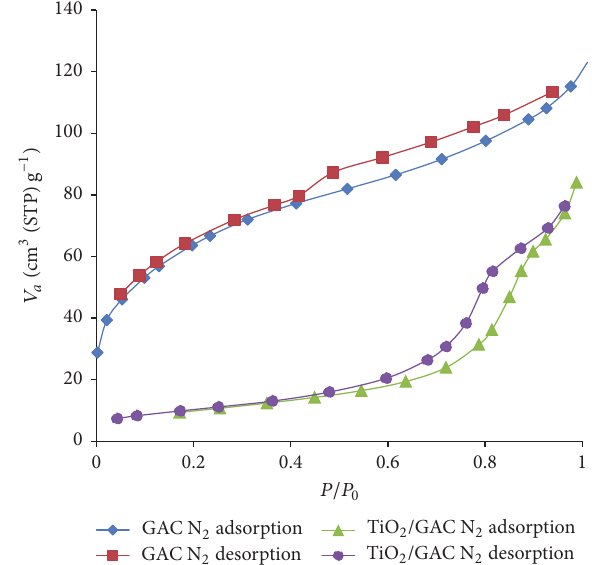
Figure 4: Nitrogen adsorption isotherms for the TiO 2 /GAC com- posite and